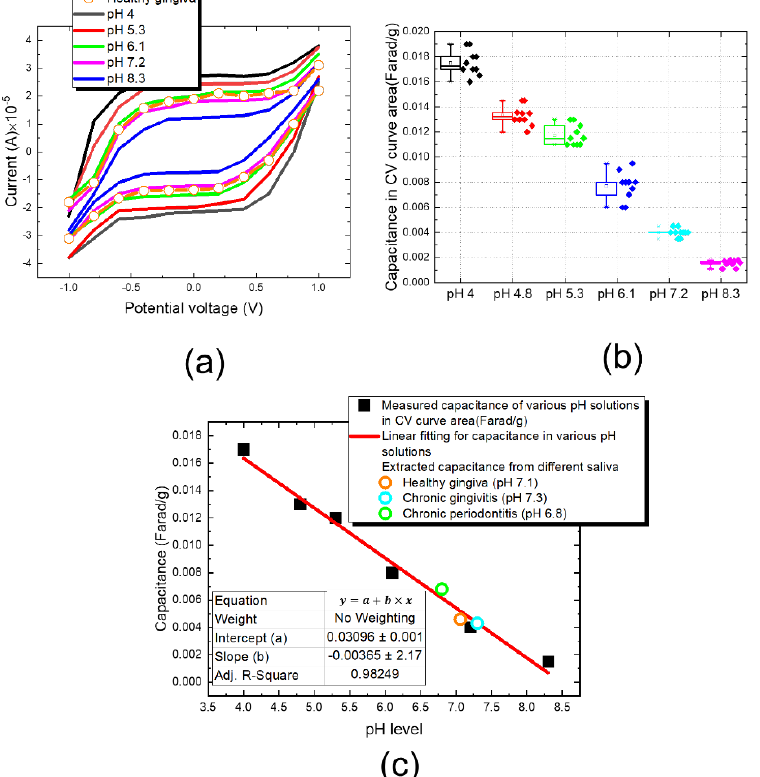
Figure 21. Investigation of various pH solutions and chronic disease gingiva saliva studied by using cyclic voltammetry (CV) method. ( a ) The relationship between measurement current and scan voltage, and ( b ) the capacitance integration under the area of CV curve in ( a , c ) the fitted curve (red line) covers the measured capacitances of three artificial disease saliva.